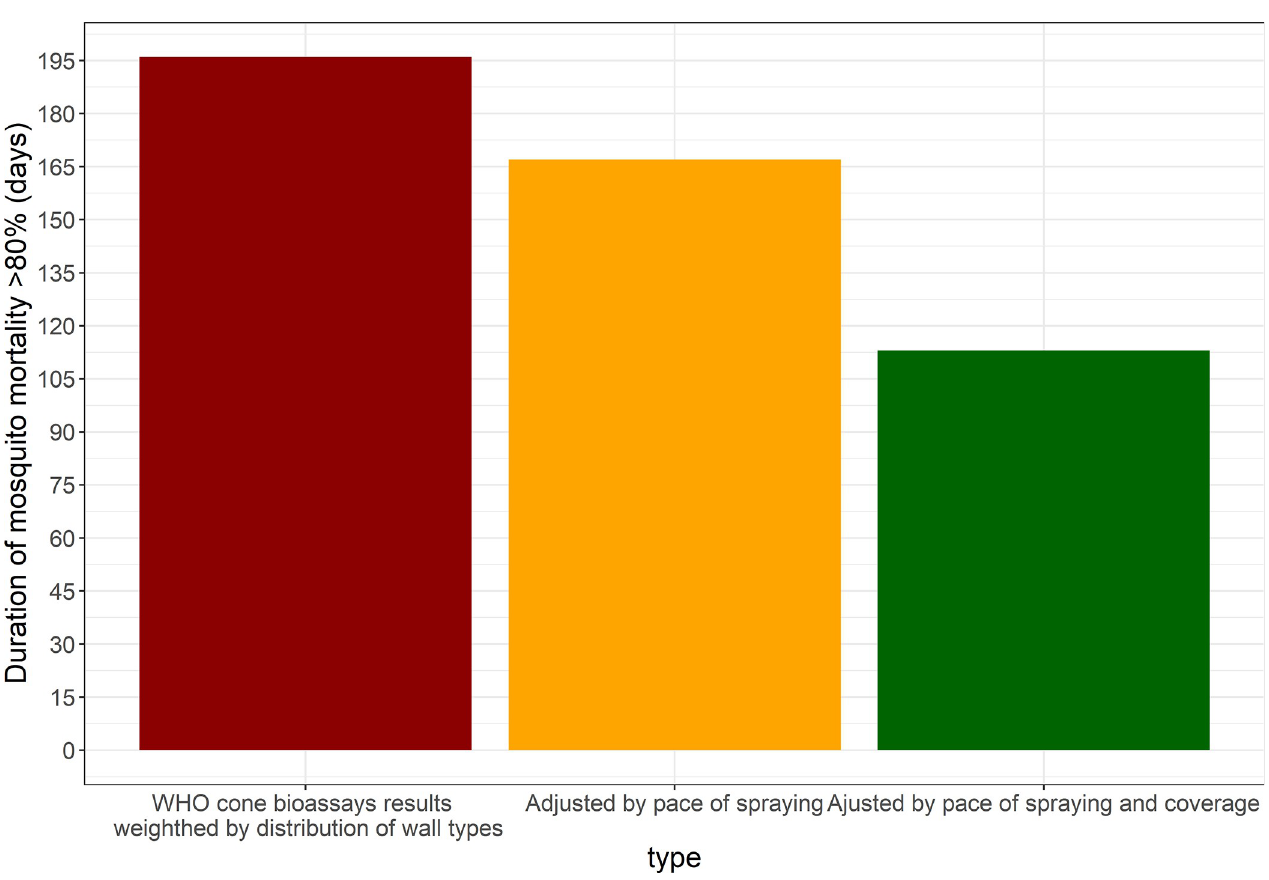
Fig 5. Reduction in the estimated duration of the 2016 IRS campaign residual efficacy after adjusting for wall type distribution, pace of household spraying and IRS coverage.